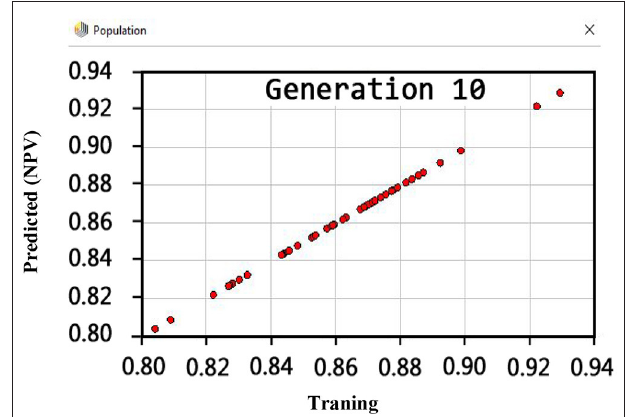
FIGURE 6 | PPV diagram for GSVNA method for generation 10.